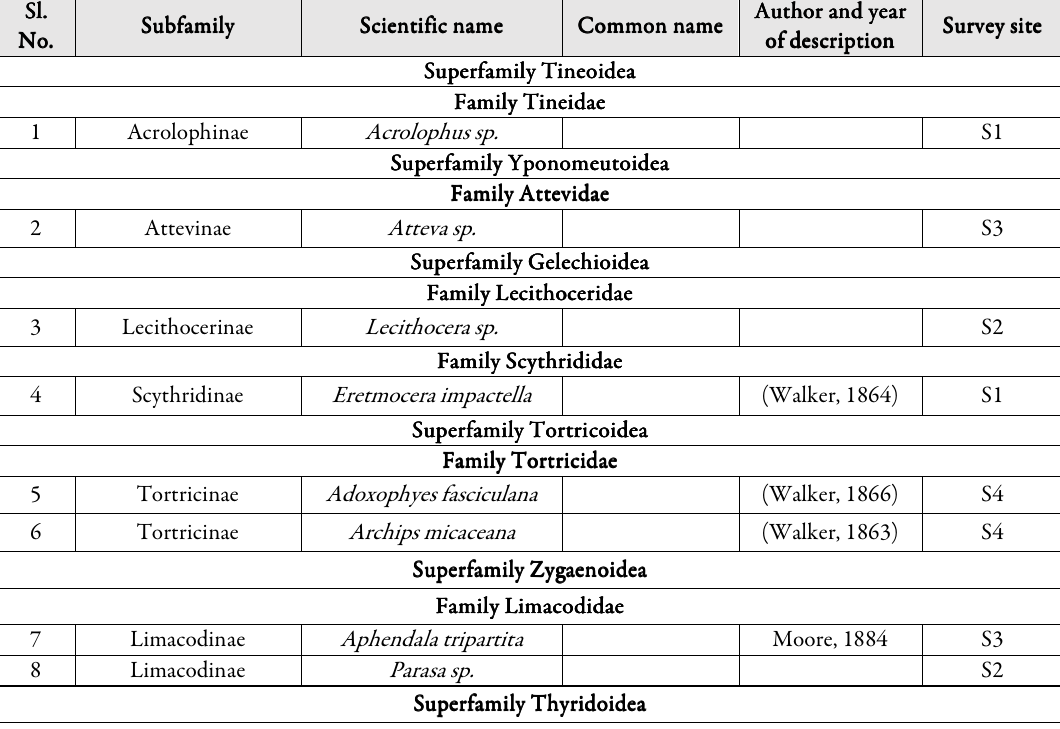
Table 2. Preliminary checklist of moths recorded during the study at various study sites Sl.